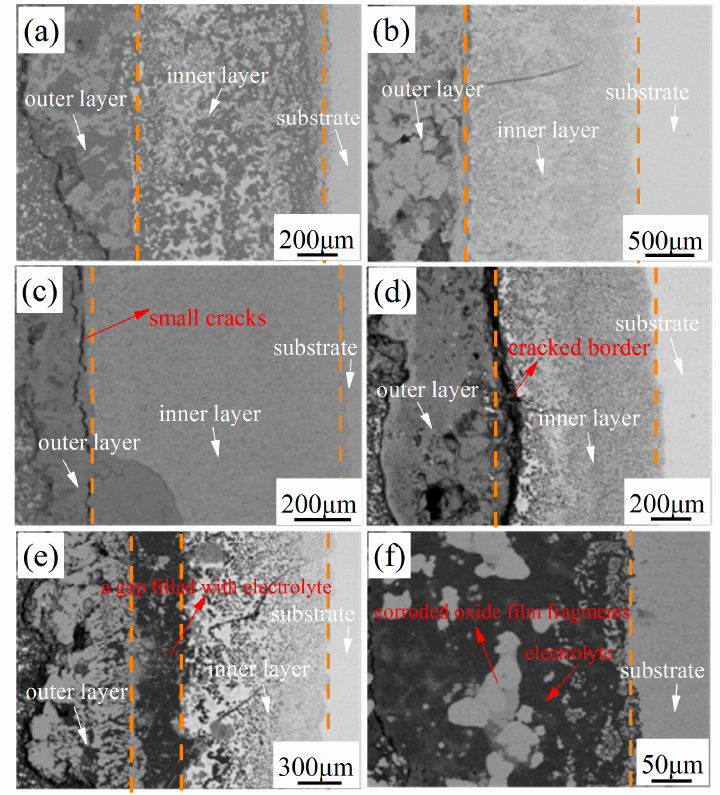
Figure 2. X-Ray diffraction patterns with respect to 1.4–4.4 wt.% Al ( a ) and 5.3–8.6 wt.% Al ( b ) of Fe-Ni-Al anodes after electrolysis.